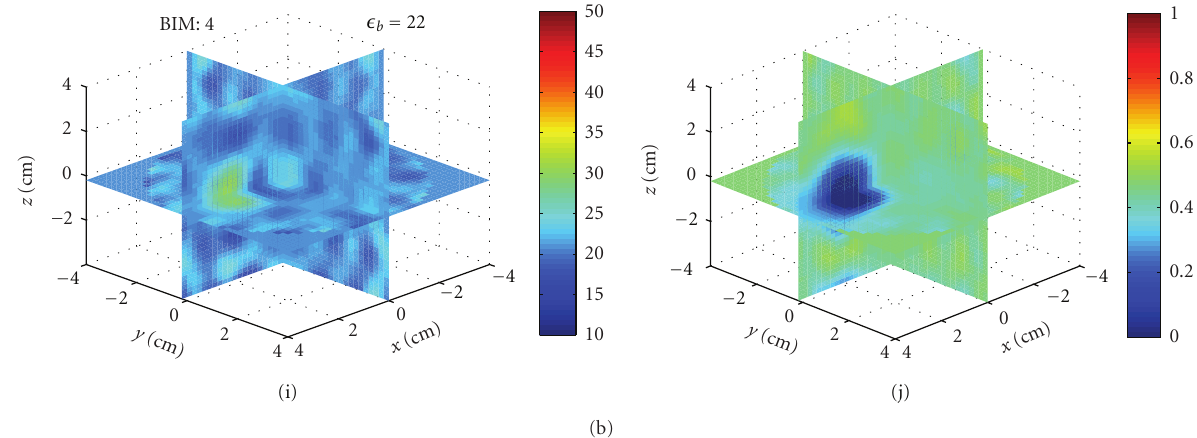
Figure 18: Sensitivity of image reconstructions to background permittivity for Example 4. (a), (c), (e), (g), and (i) and (b), (d), (f), (h), and (j) Relative permittivity and conductivity, respectively. The scattered field data was generated in HFSS in a background of (21, 0.475). The reconstructions are done with assumed background relative permittivities of 20, 20.5, 21, 21.5, 22 for (a) and (b), (c) and (d), (e) and (f), (g) and (h) and (i) and (j), respectively. The recovered contrasts of the sphere oscillate about the